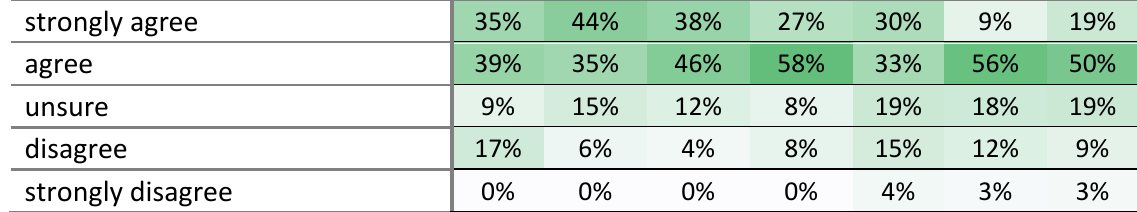
Table 27: Respondents ’ perceptions from 2014 to